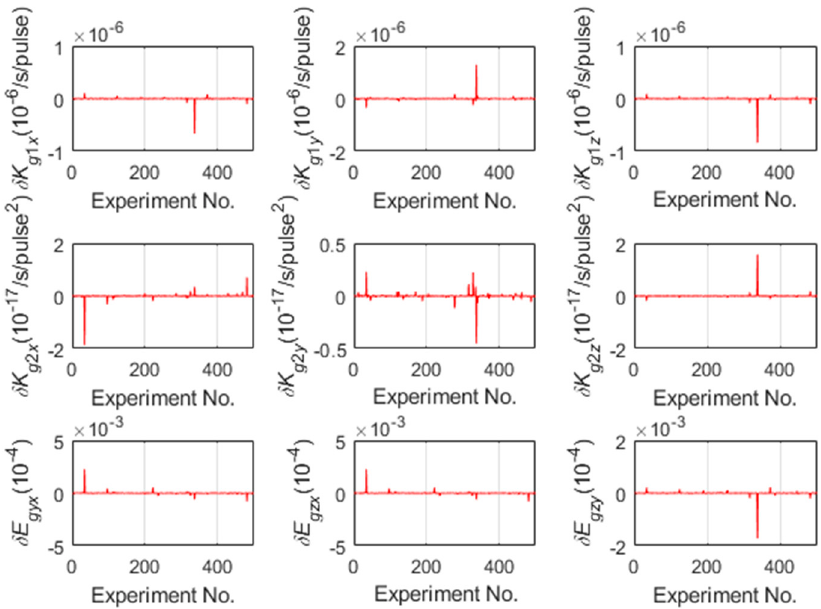
Figure 5. The calibration errors of gyroscope with the initial values estimation.